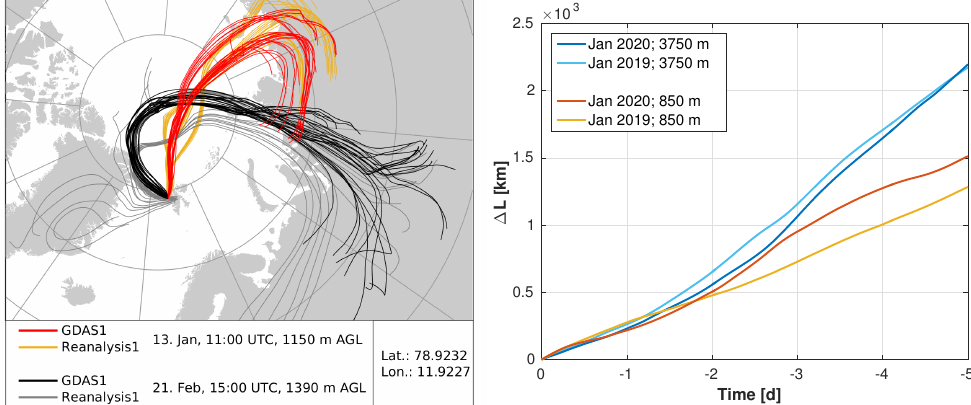
Figure A2. ( Left ): Comparison between the trajectories calculated with Reanalysis1 and with GDAS1. Both models used the same start parameters; ( Right ): mean difference between the trajectories of GDAS1 and Reanalysis1. All trajectories were calculated for the whole month every 12 h with the same start